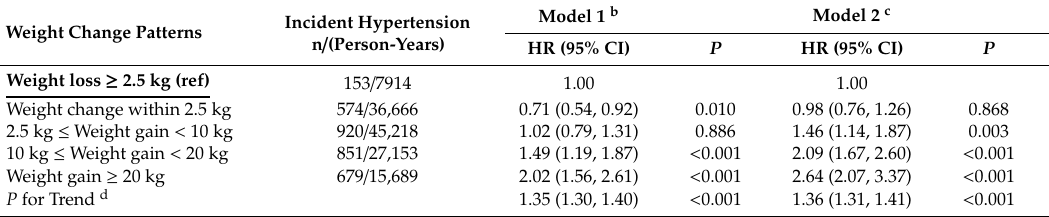
Table 3. Hazard ratios (HRs) and 95% confidence intervals (CIs) of incident hypertension with absolute weight change patterns across adulthood a .